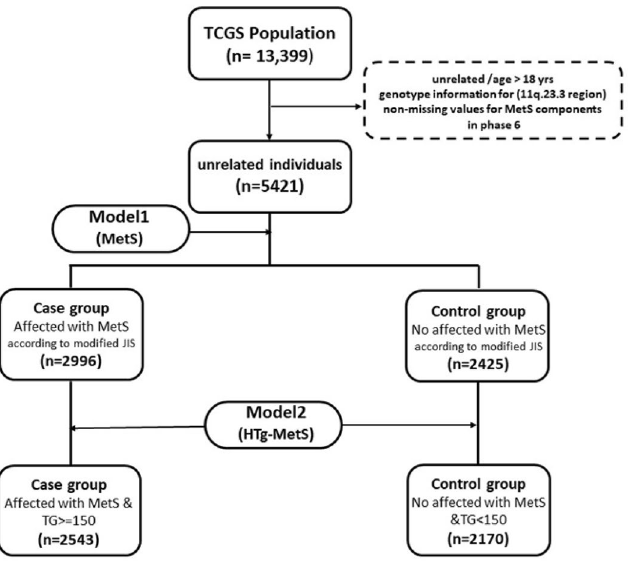
Figure 5. Flow diagram of the study. Model 1 and Model 2 shows by MetS and HTg-MetS symbols,